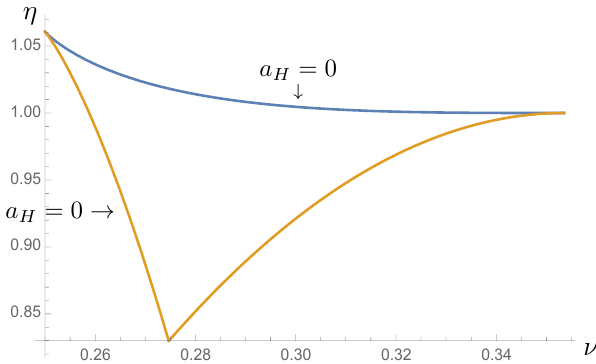
p 2). The allowed region is